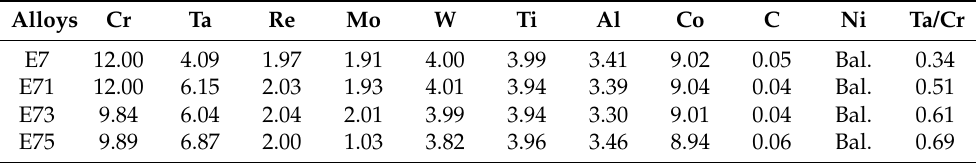
Table 1. Chemical compositions of the experimental alloys (wt.